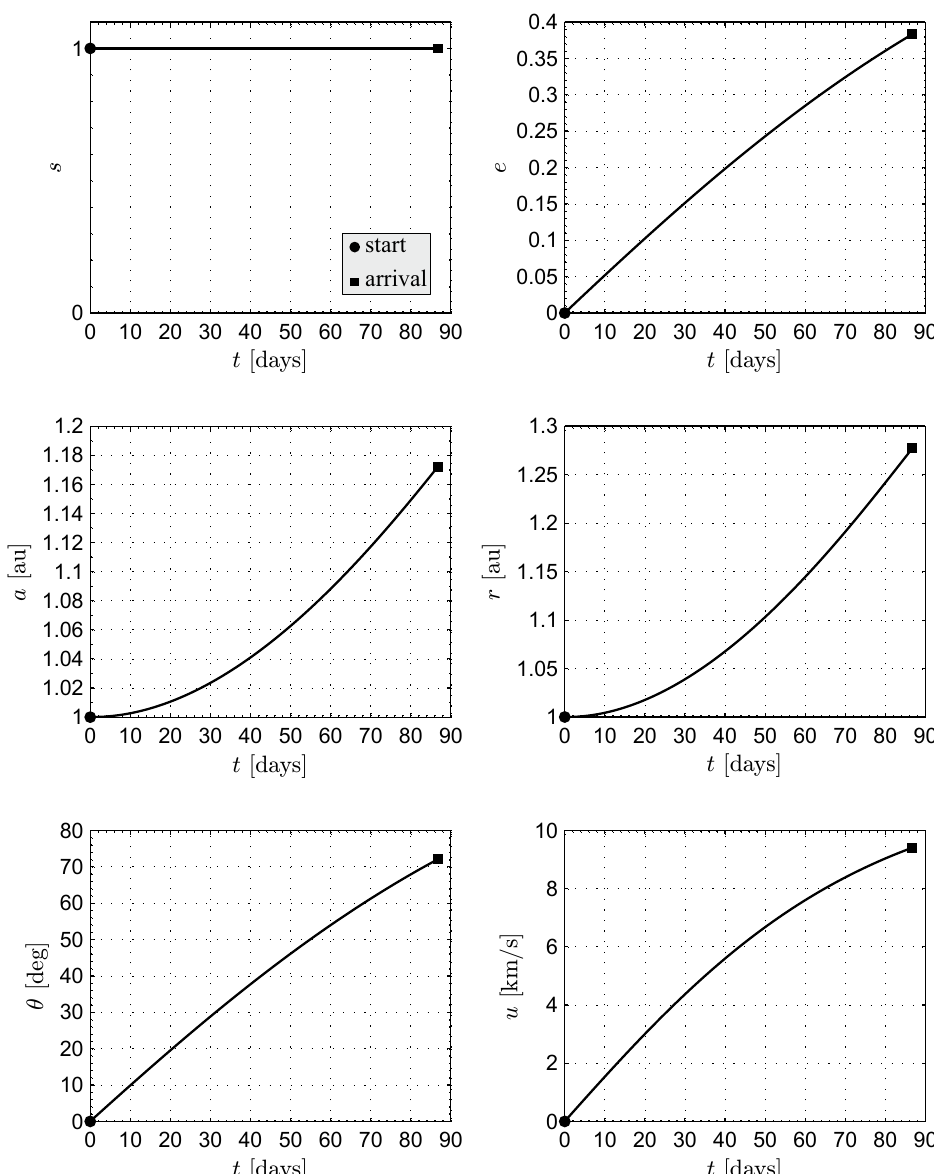
Figure 15. Transfer trajectory characteristics in a Venus-based mission scenario with e f = 0.3831 and β =